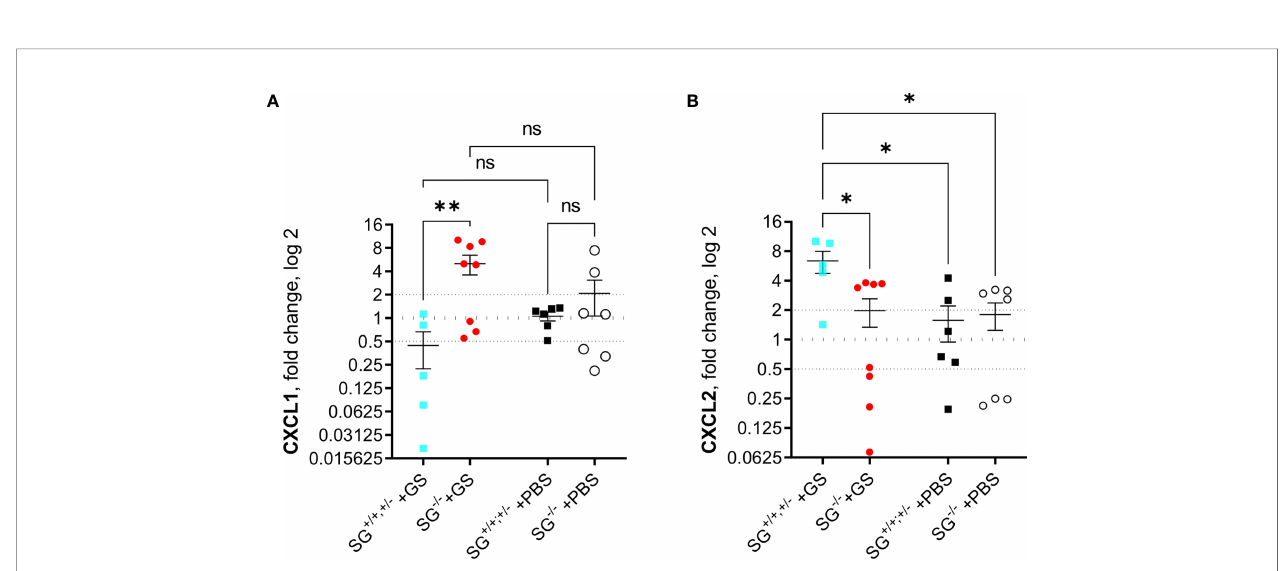
FIGURE 5 | Intestinal expression levels of chemokines in Giardia intestinalis -infected SG +/+ and SG -/- littermate mice. Relative expression levels at day 12 post infection of (A) CXCL1 and (B) CXCL2 determined by qPCR. Fold changes were calculated after normalization to GAPDH. Dotted lines at 0.5, 1, and 2 Indicates down-regulation, no fold change, and up-regulation, respectively. ns, non-signi fi cant, P values * <0.05, ** <0.01 are